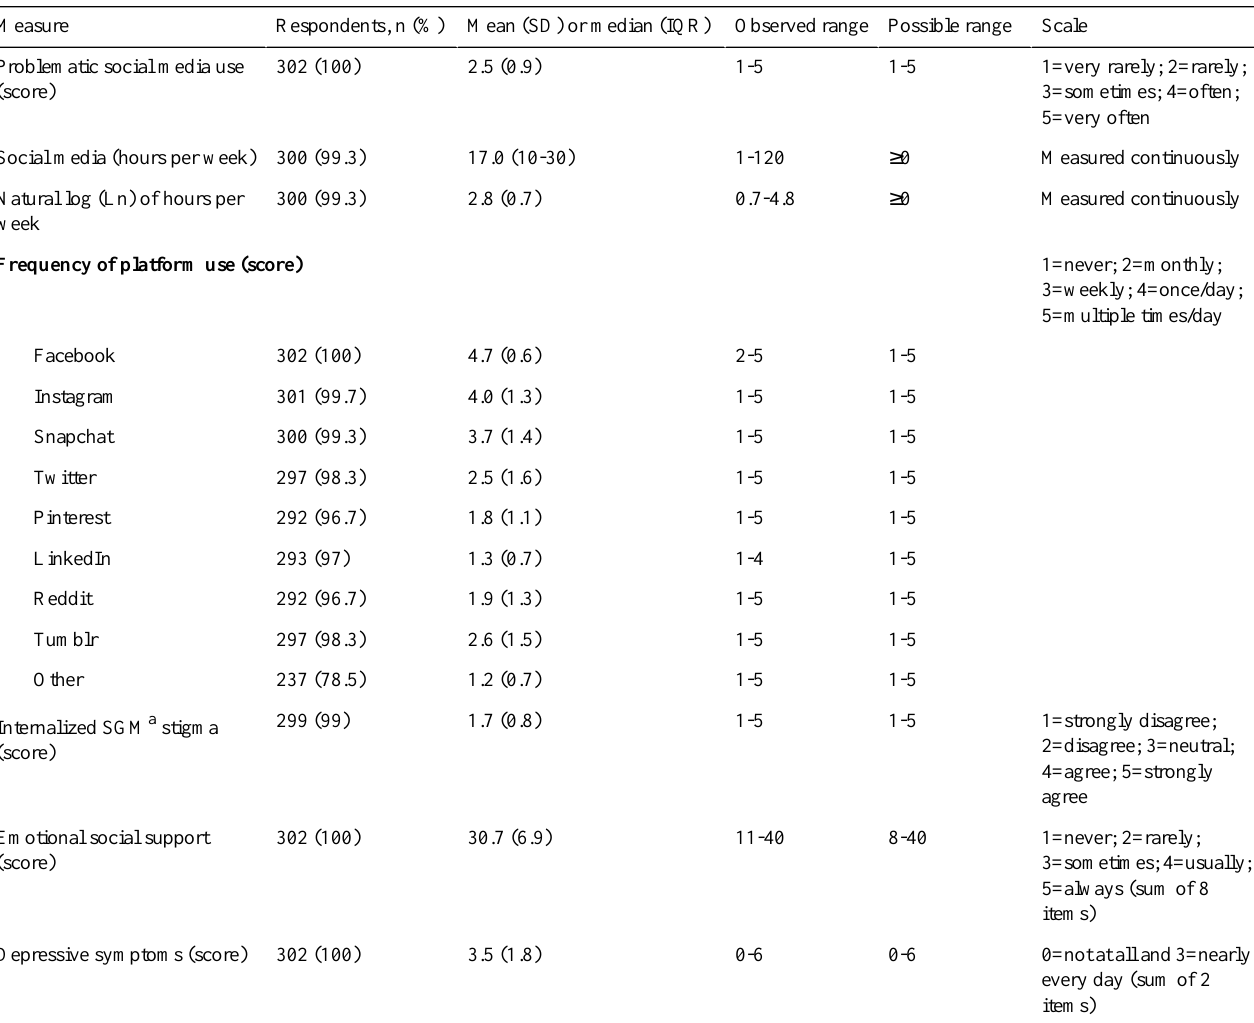
Table 2. Distributions of key